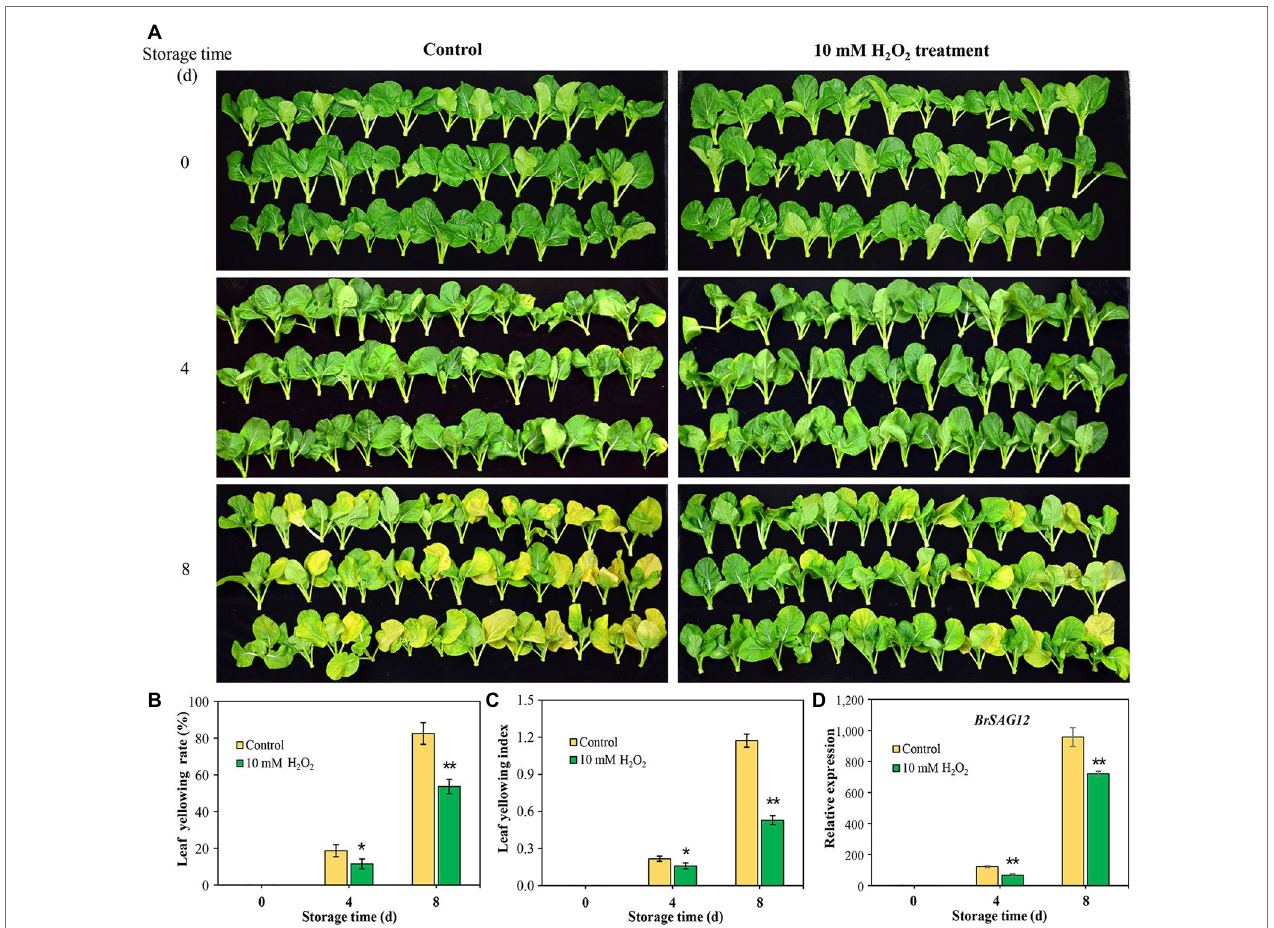
FIGURE 1 | Exogenous hydrogen peroxide (10 mM H 2 O 2 ) alleviates leaf senescence in Chinese flowering cabbage, as is shown by leaf yellowing symptom (A) , leaf yellowing rate (B) , leaf yellowing index (C) , and relative expression of senescence-associated gene (SAG) BrSAG12 (D) in leaves during storage. Error bars represent one SD. Asterisks indicate that the mean values of H 2 O 2 treatment are significantly different from those of the control (* p < 0.05, ** p < 0.01), according to Duncan’s multiple range